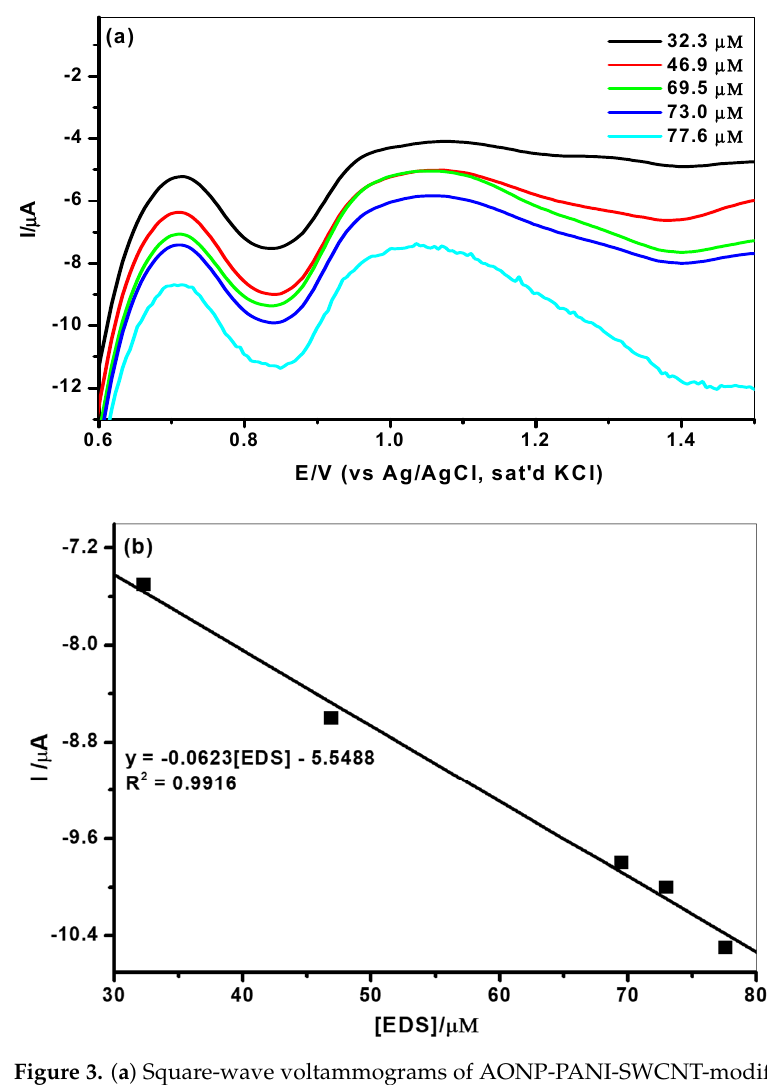
Figure 3. ( a ) Square-wave voltammograms of AONP-PANI-SWCNT-modified GCE in 32.3 µM to 77.6 µM EDS prepared in 2:1 water/acetonitrile containing 0.1 M H 2 SO 4 . ( b ) The plot of current response versus EDS concentration. Table 1. Analytical performance of the proposed sensor for electrochemical detection of EDS.